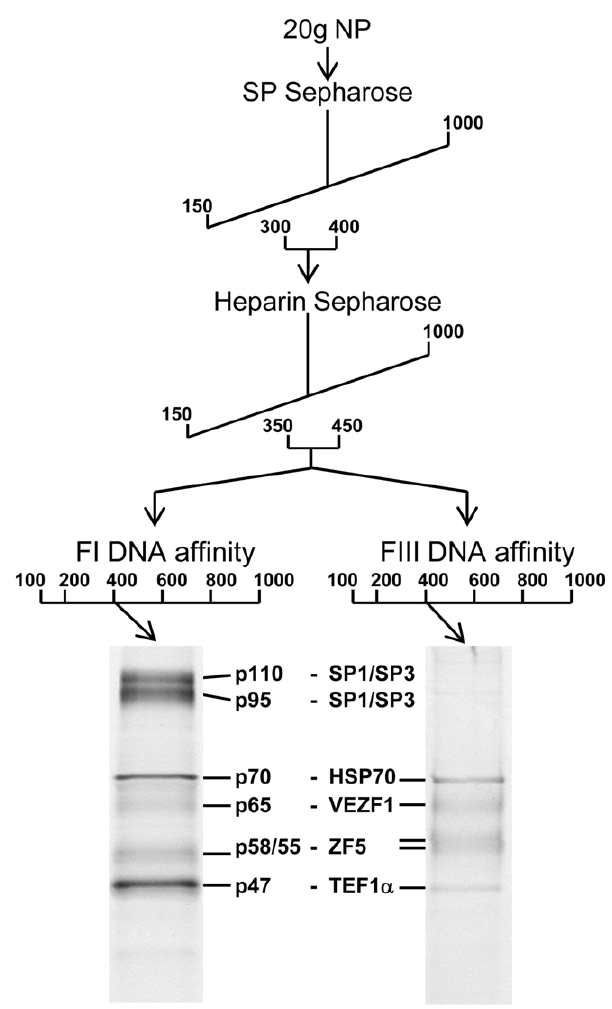
Figure 5. Purification of FI- and FIII-binding proteins. Schematic representation of the steps used to purify DNA-binding proteins from adult erythrocyte nuclear protein (NP) extracts that interact with FI and FIII sequences. Numbers in the workflow indicate the salt concentration (mM) at which DNA binding factors eluted from each column. DNA binding activity was tracked using gel mobility shift analysis and the sequence specificity of complex-forming factors was checked by competition analysis following each purification stage (data not shown). FI- and FIII-binding activities exactly co-purified. The eluate pool from the Heparin step was split in two prior to either FI or FIII DNA affinity chromatography. SDS-PAGE of proteins eluted from DNA affinity columns at 400 mM KCl visualized with colloidal Coomassie is shown below. The size of each polypeptide (kDa) is indicated.